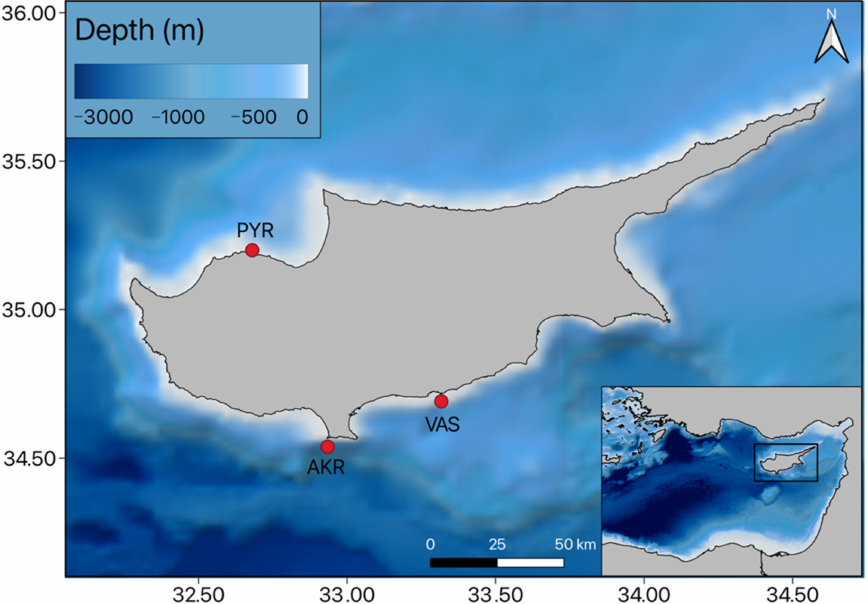
Figure 1. Bathymetry map around Cyprus at the eastern Mediterranean Sea, indicating the three sampling stations, Pyrgos (PYR), Akrotiri (AKR) and Vasilikos Fish Farm (VAS). Bathymetric data obtained from the National Geophysical Data Centre (NGDC) database ETOPO1 [46,47], and coastline data obtained from